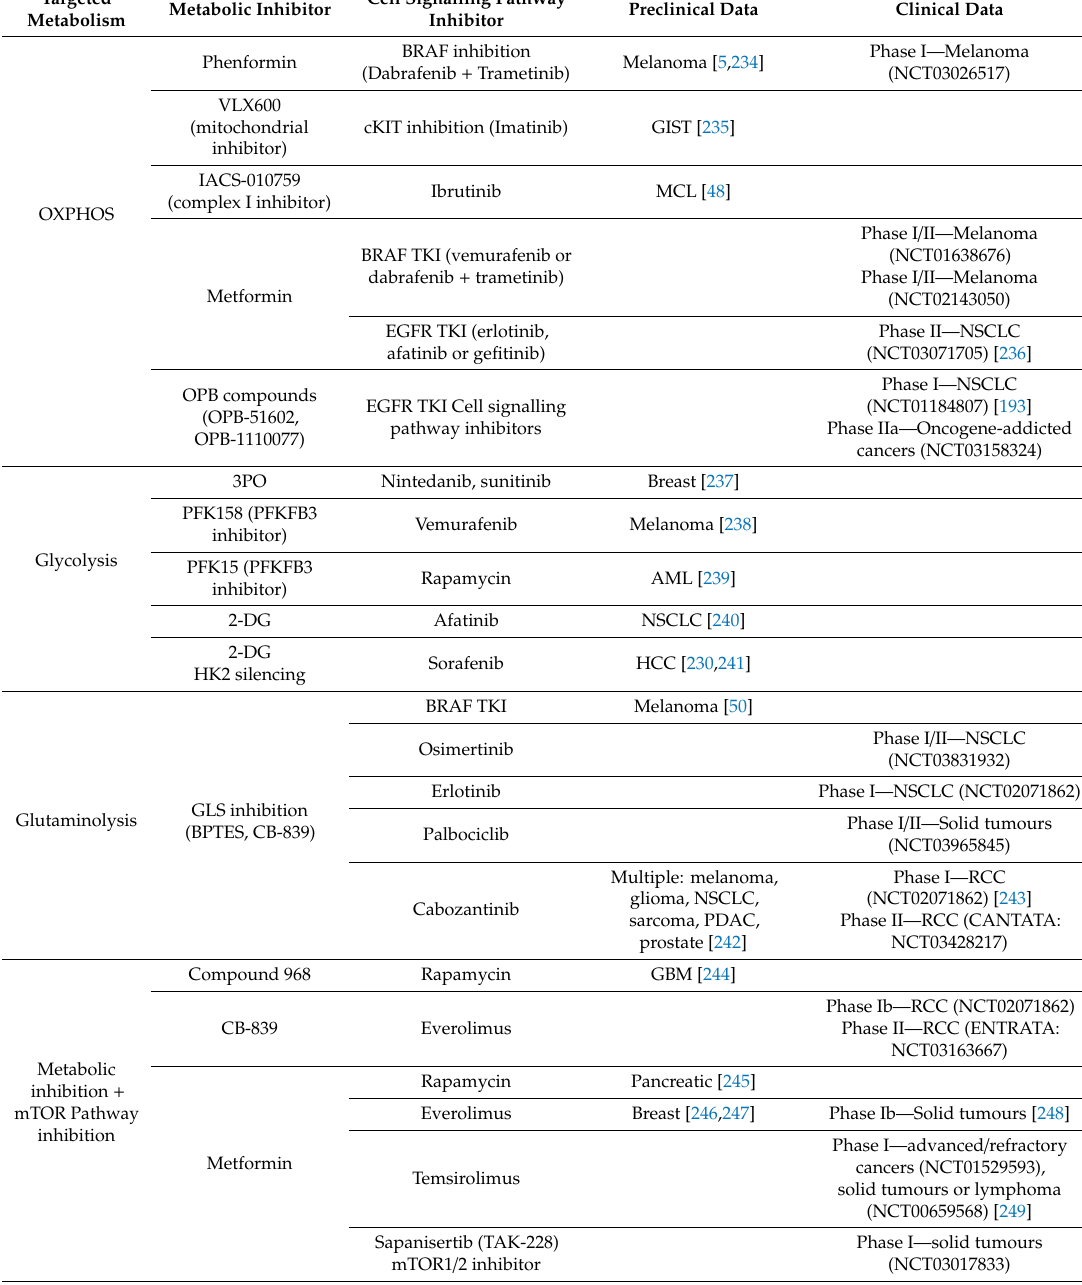
Table 2. Metabolic inhibitors in combination with targeted therapy for cancer therapy.